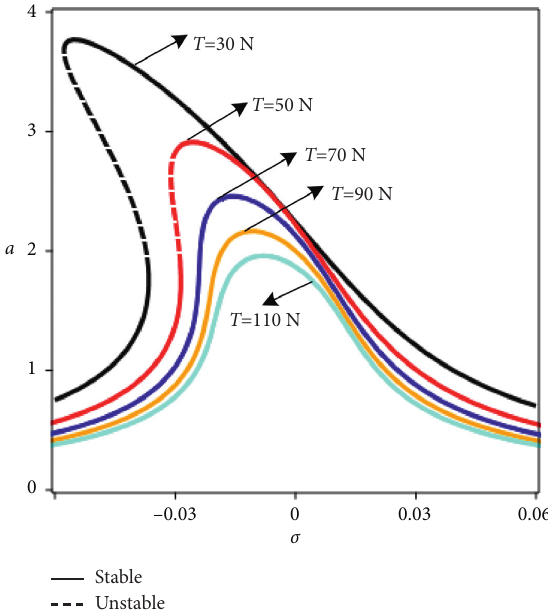
Figure 9: The amplitude-frequency response curve of primary resonance (varied T ).